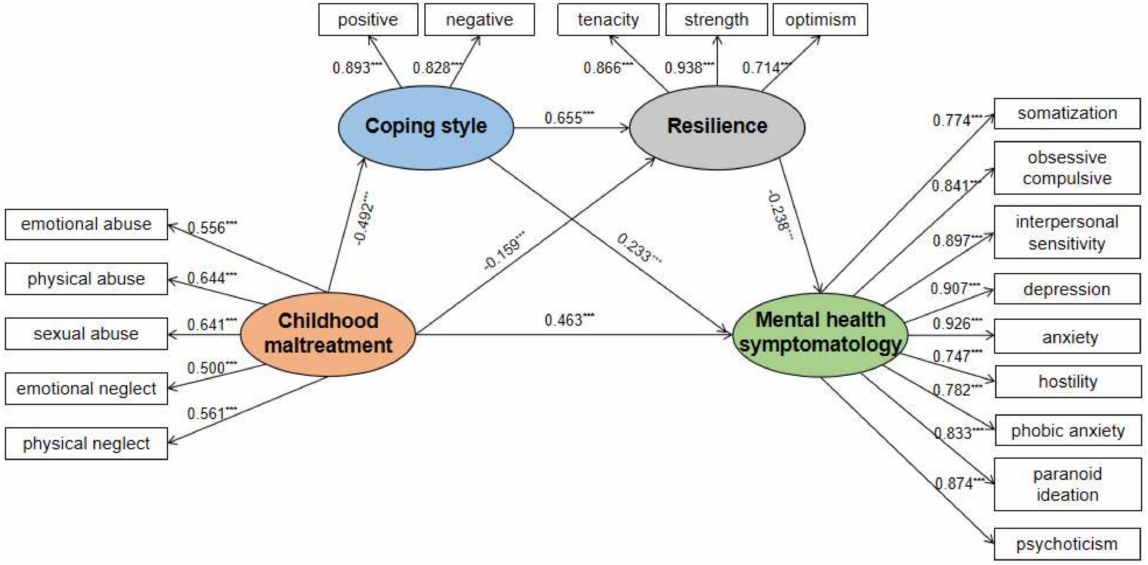
Figure 2. Final model: the influencing direction of coping style and resilience was the same compared to the hypothetical model. Note: *** means p <